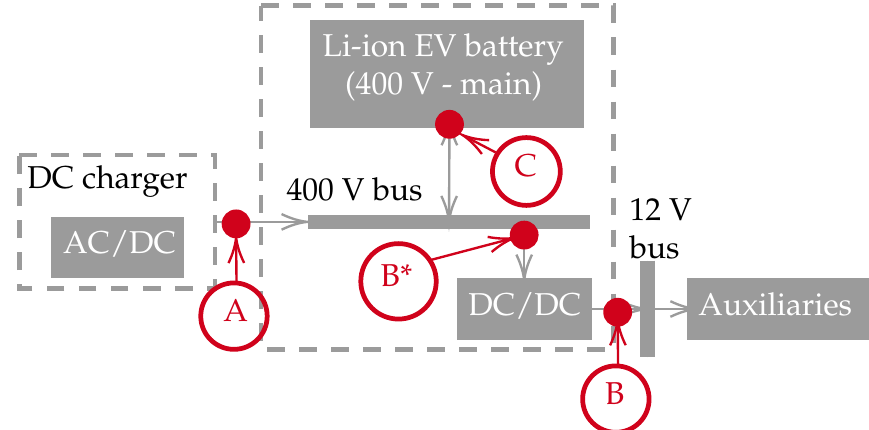
Figure 4. Measurement location overview. In A and B, voltage and current are measured with the external equipment. The BMS voltage and current data are measured from point C. B* is the derived current measurement with the external